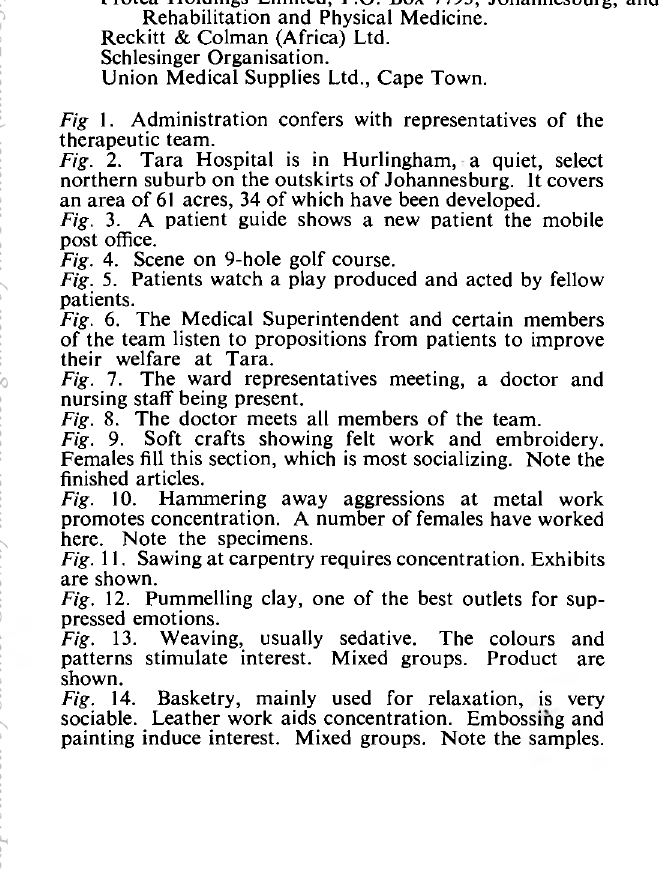
Fig. 15. A female class at relaxation. Fig. 16. Art therapy must be done in a quiet atmosphere. The doctor listens to patients’ interpretations of drawings, which assist in diagnosis.